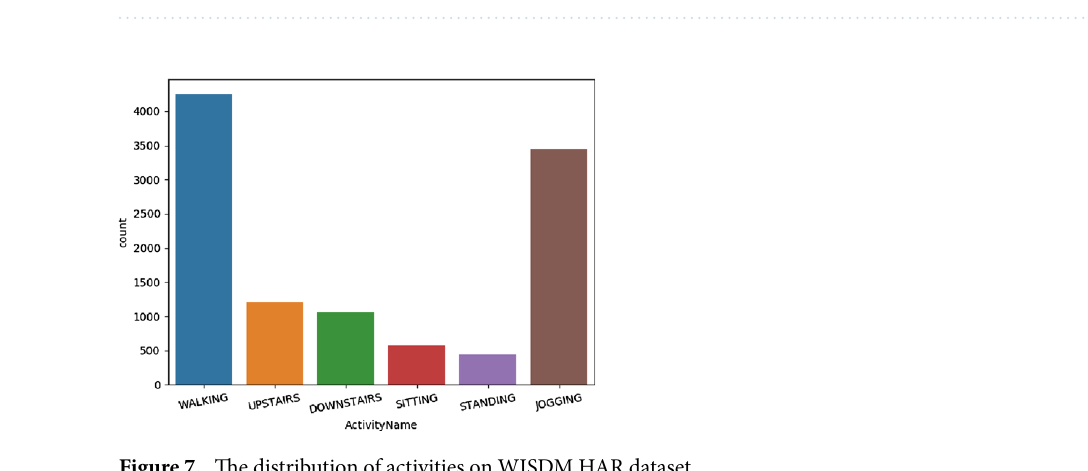
Figure 6. The boxplot of acceleration magnitude on original and revised UCI HAR dataset.